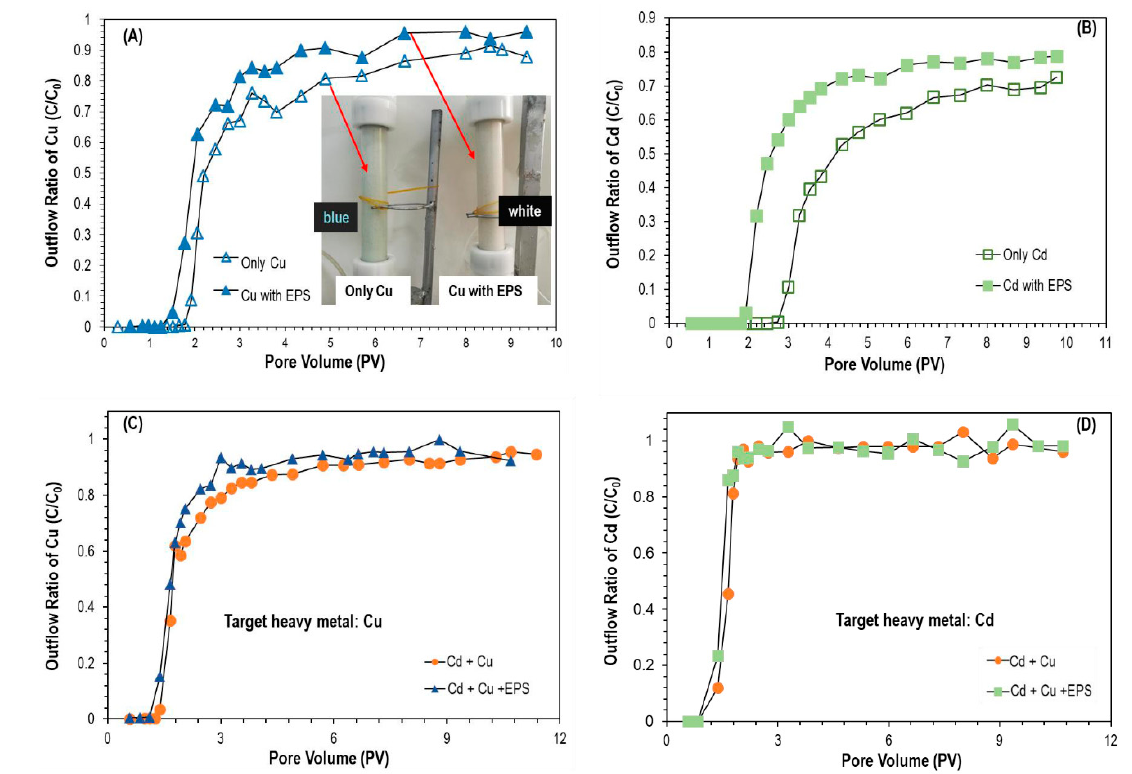
Figure 5. Migration experiments carried out on EPS and metal ions under different conditions: ( A , B ) migration of Cu/Cd in the presence or absence of EPS; ( C , D ) effect of Cu and Cd co-migration in the presence of EPS.